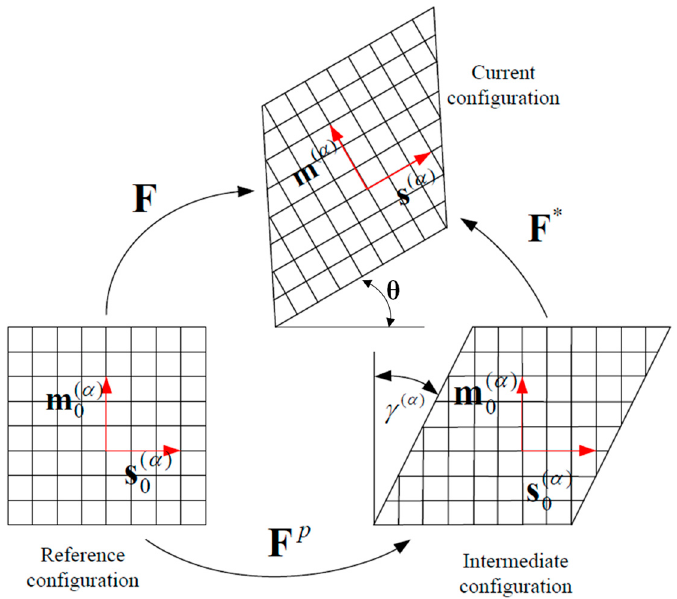
Figure 1. Kinematic diagram of crystal elastoplastic deformation